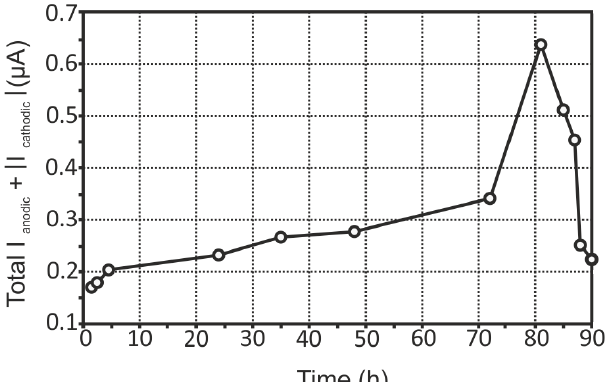
Figure 11. The evolution of the sum of total cathodic and anodic currents for the 1579 aluminium alloy sample with a welded joint. Increasing of the electrochemical activity was detected during the exposure of the specimen.